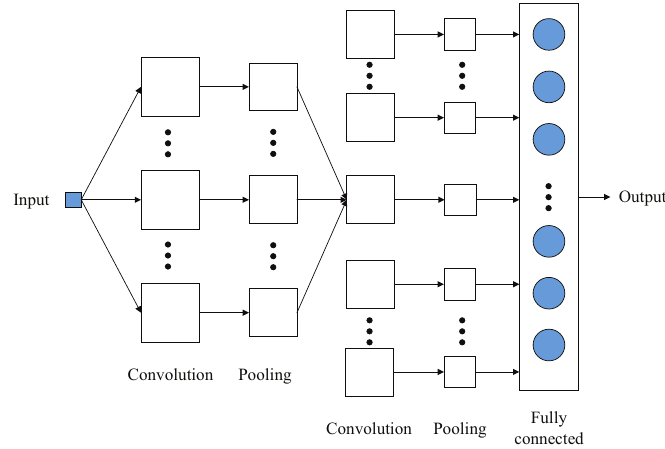
Figure 5. The network structure of Convolutional Neural